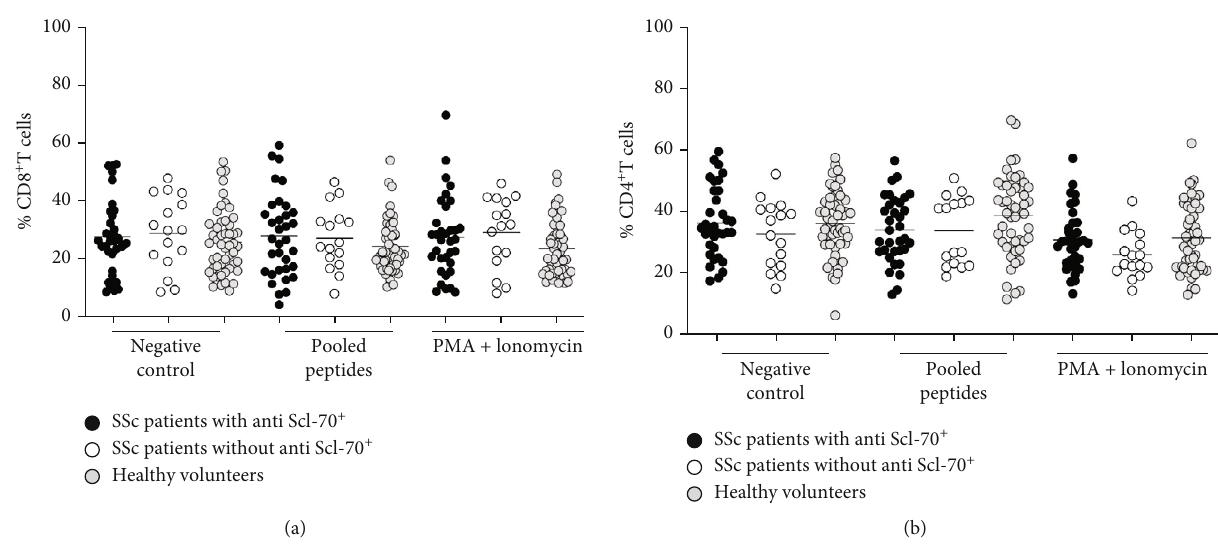
Figure 3: The number of CD4 + (a) and CD8 + (b) T cells in SSc patients ( n = 50 ) and healthy volunteers ( n = 50